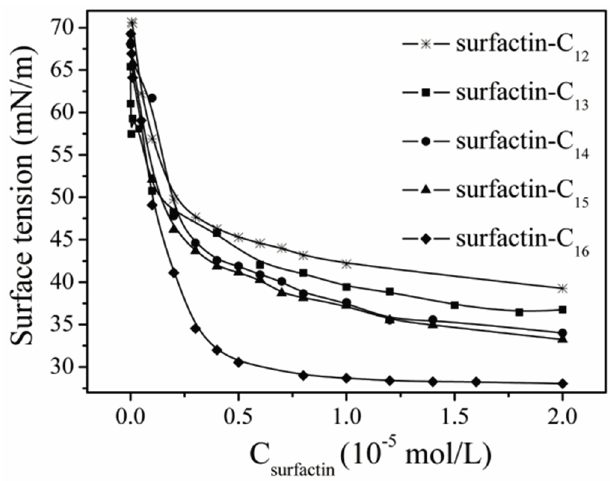
Figure 7. Surface tension of surfactins with different fatty acid chain length [51].